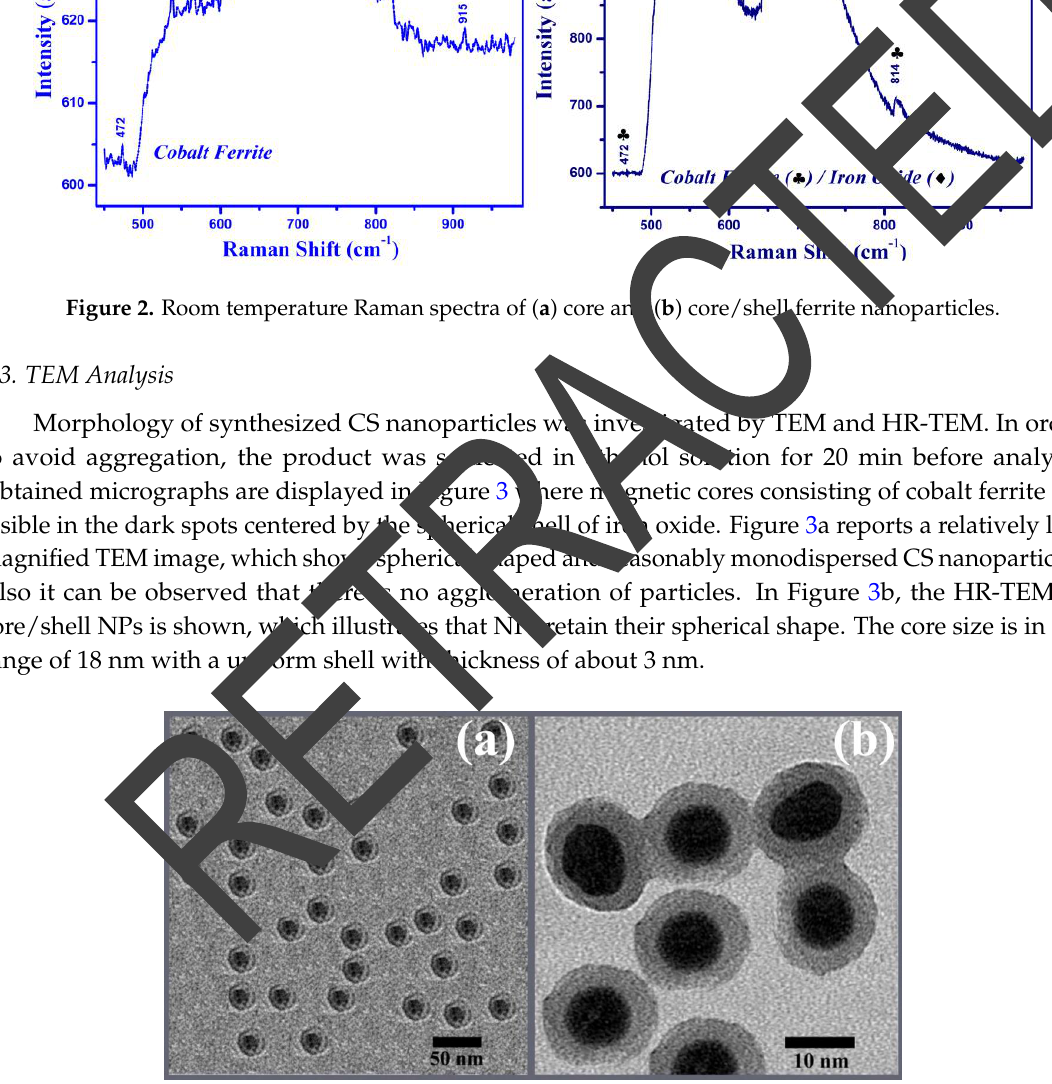
Figure 3. ( a ) Transmission electron microscopy (TEM) image of core/shell nanoparticles; ( b ) high resolution (HR)-TEM image of core/shell